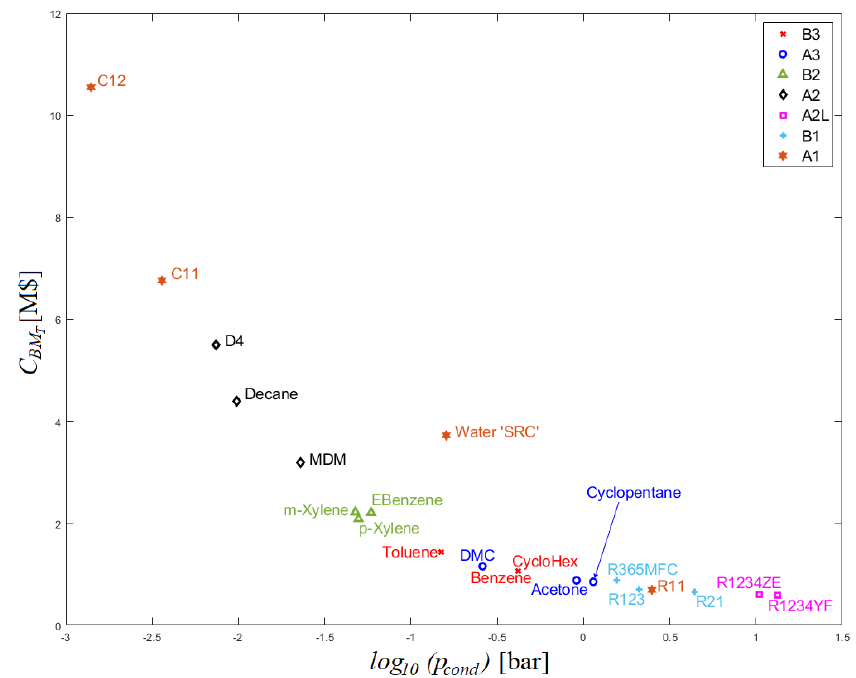
Figure 10. Plant cost versus condensation pressure (in logarithmic scale) of the best 3 fluids of each safety category in the case of oil thermal